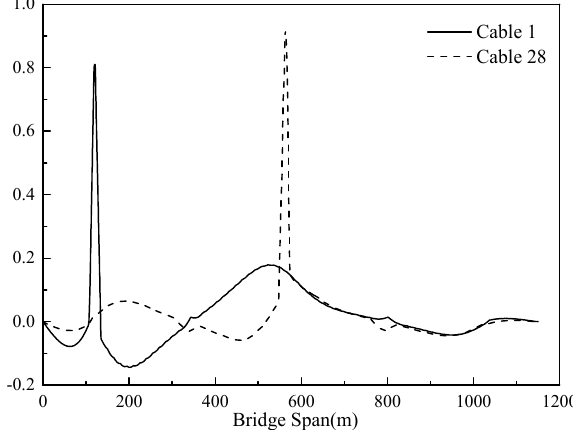
Figure 4. Influence lines of cable 1 and cable 28 on car lane 4.